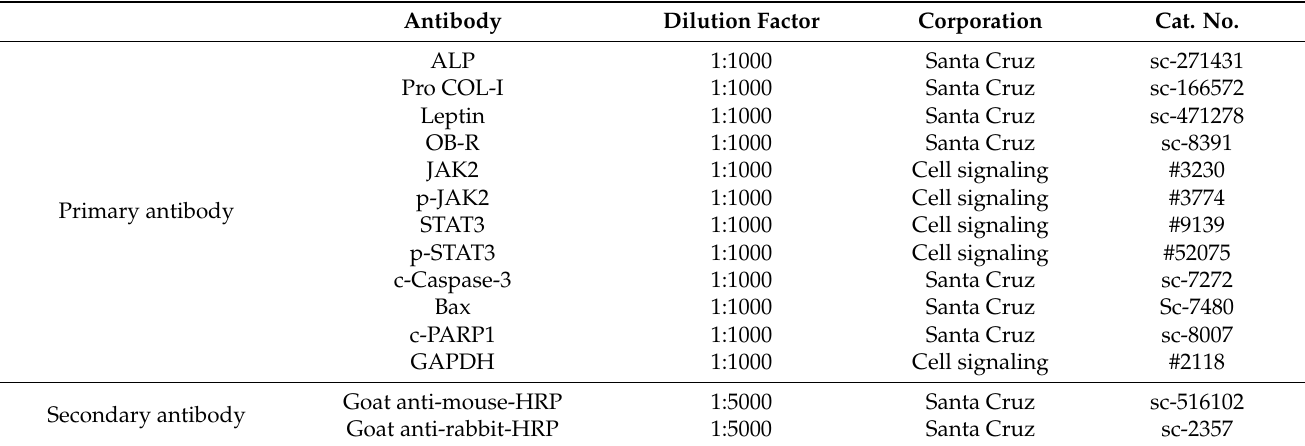
Table 2. Antibodies for western blotting